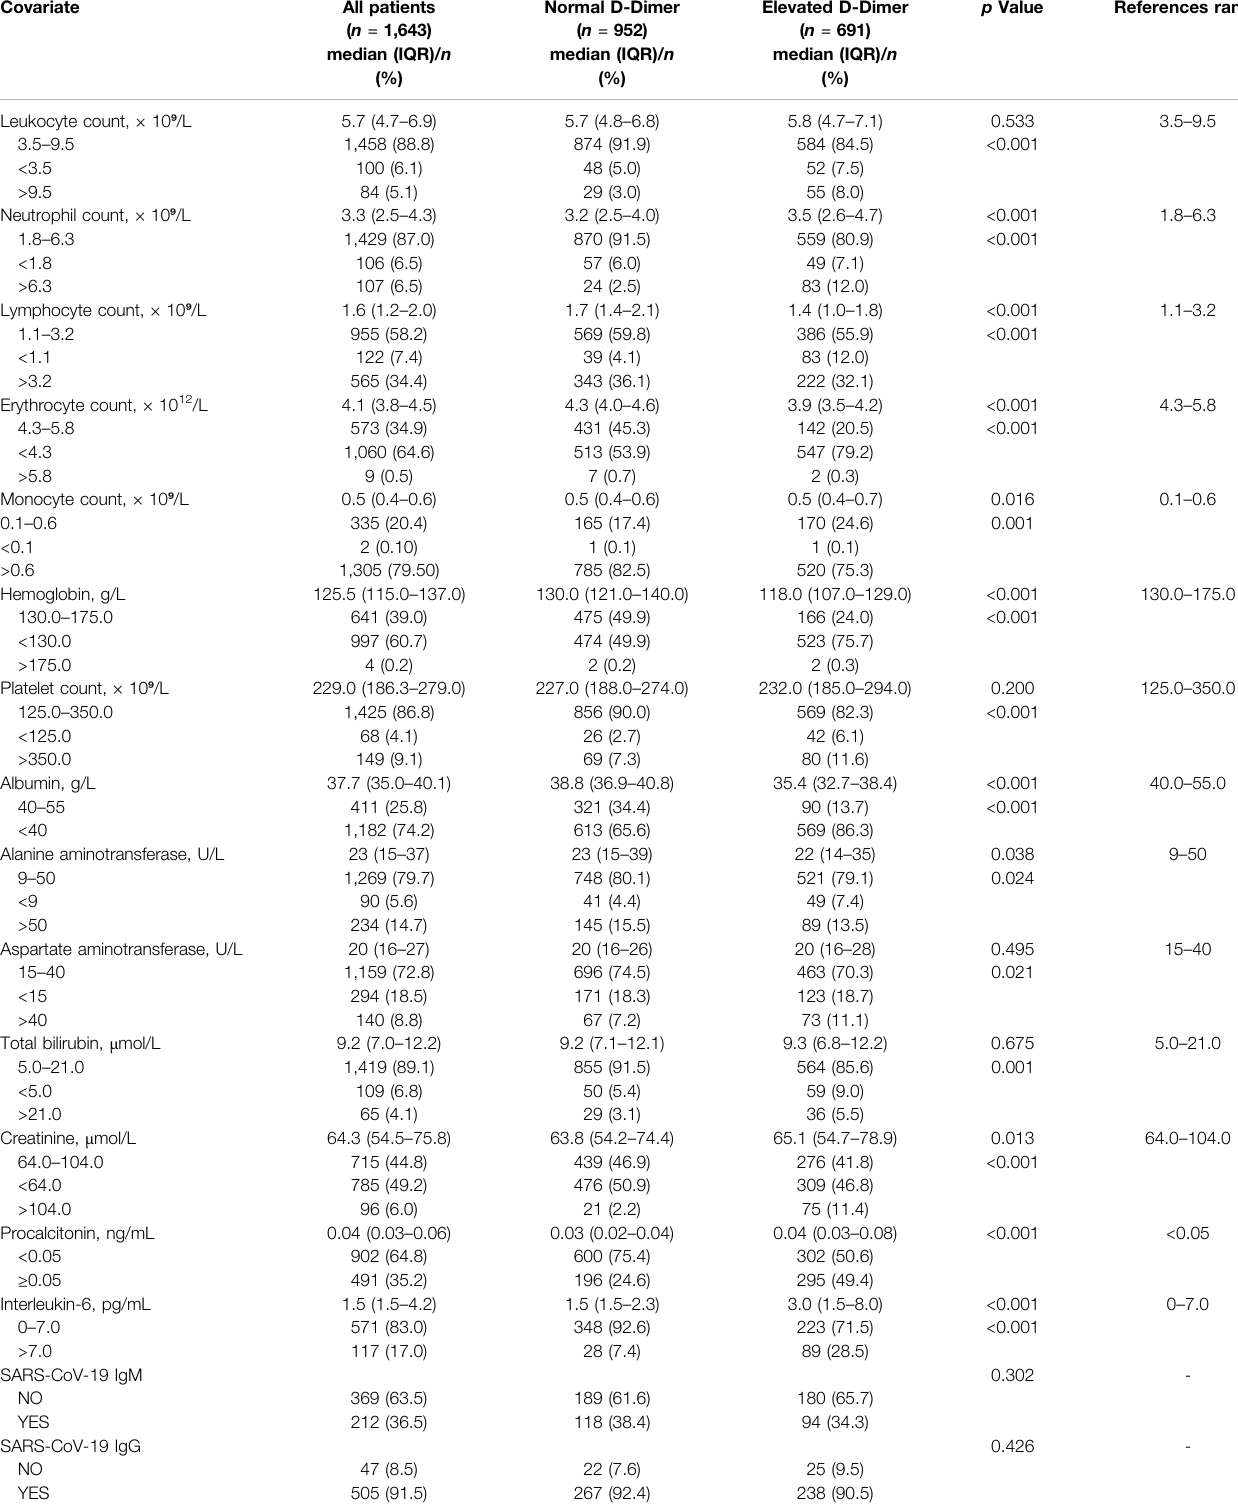
TABLE 2 | Laboratory test results of 1,643 patients with COVID-19.